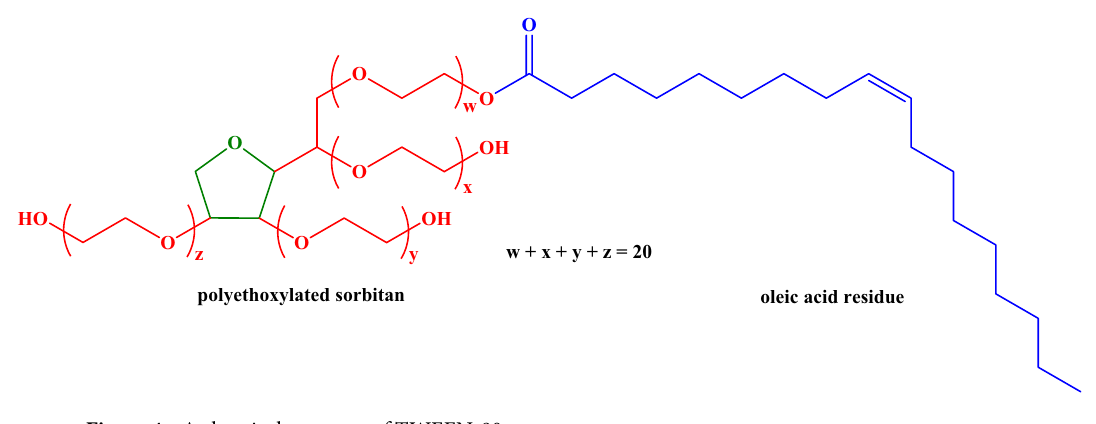
Figure 4. A chemical structure of TWEEN-80.